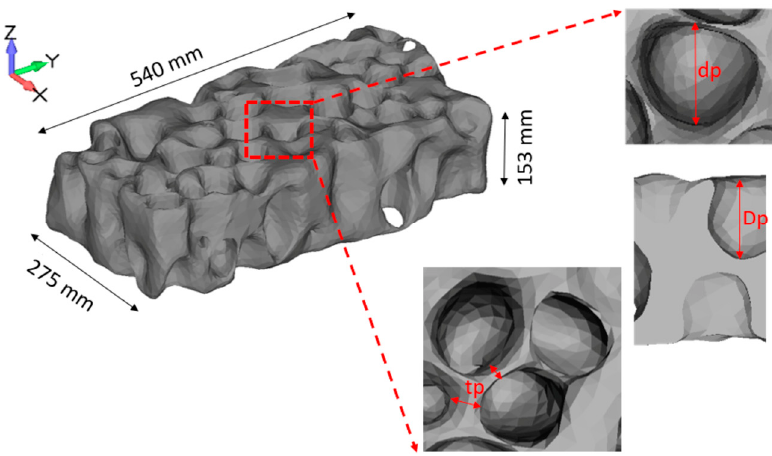
Figure 4. Creation of volume model based on CT scan images. CT scan images generated from the physical model were processed to create the sample for simulation and numerical modeling: CT scan-based computer model.